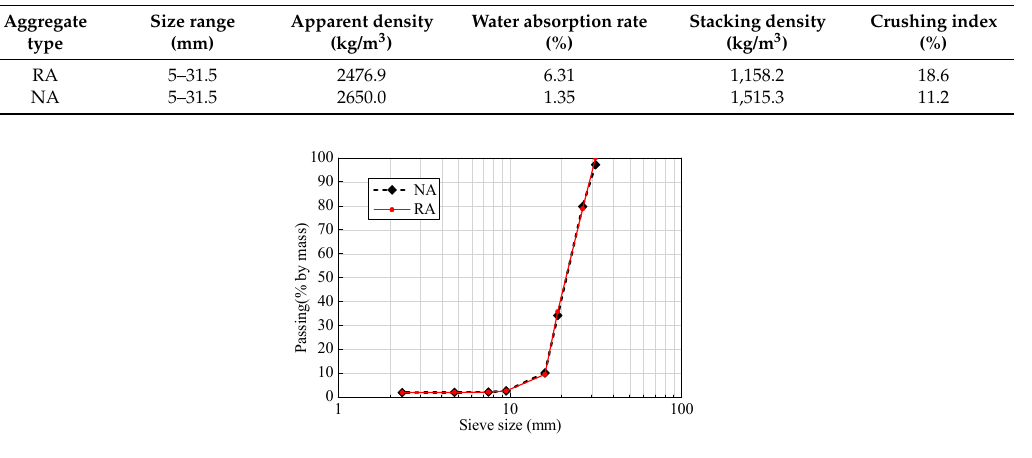
Figure 1. Gradation curve of Recycled Aggregate (RA).